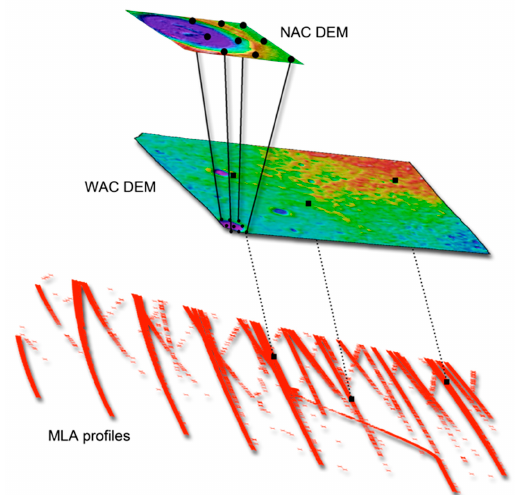
Figure 4. Tie points connecting Kertész NAC DEM ( top ; displayed as a color-shaded relief map) to an overlapping WAC DEM ( middle ; made from image pair EW0218288557G, EW0233348623G), which is controlled to MLA profiles ( bottom ) projected to Mercury’s surface . Black circles represent tie points between the NAC and WAC images, while black squares represent control points in the WAC DEM from MLA points.